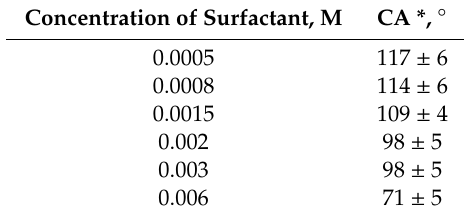
Table 1. CA of PET TeMs with Si NPs obtained at di ff erent concentration of surfactant.